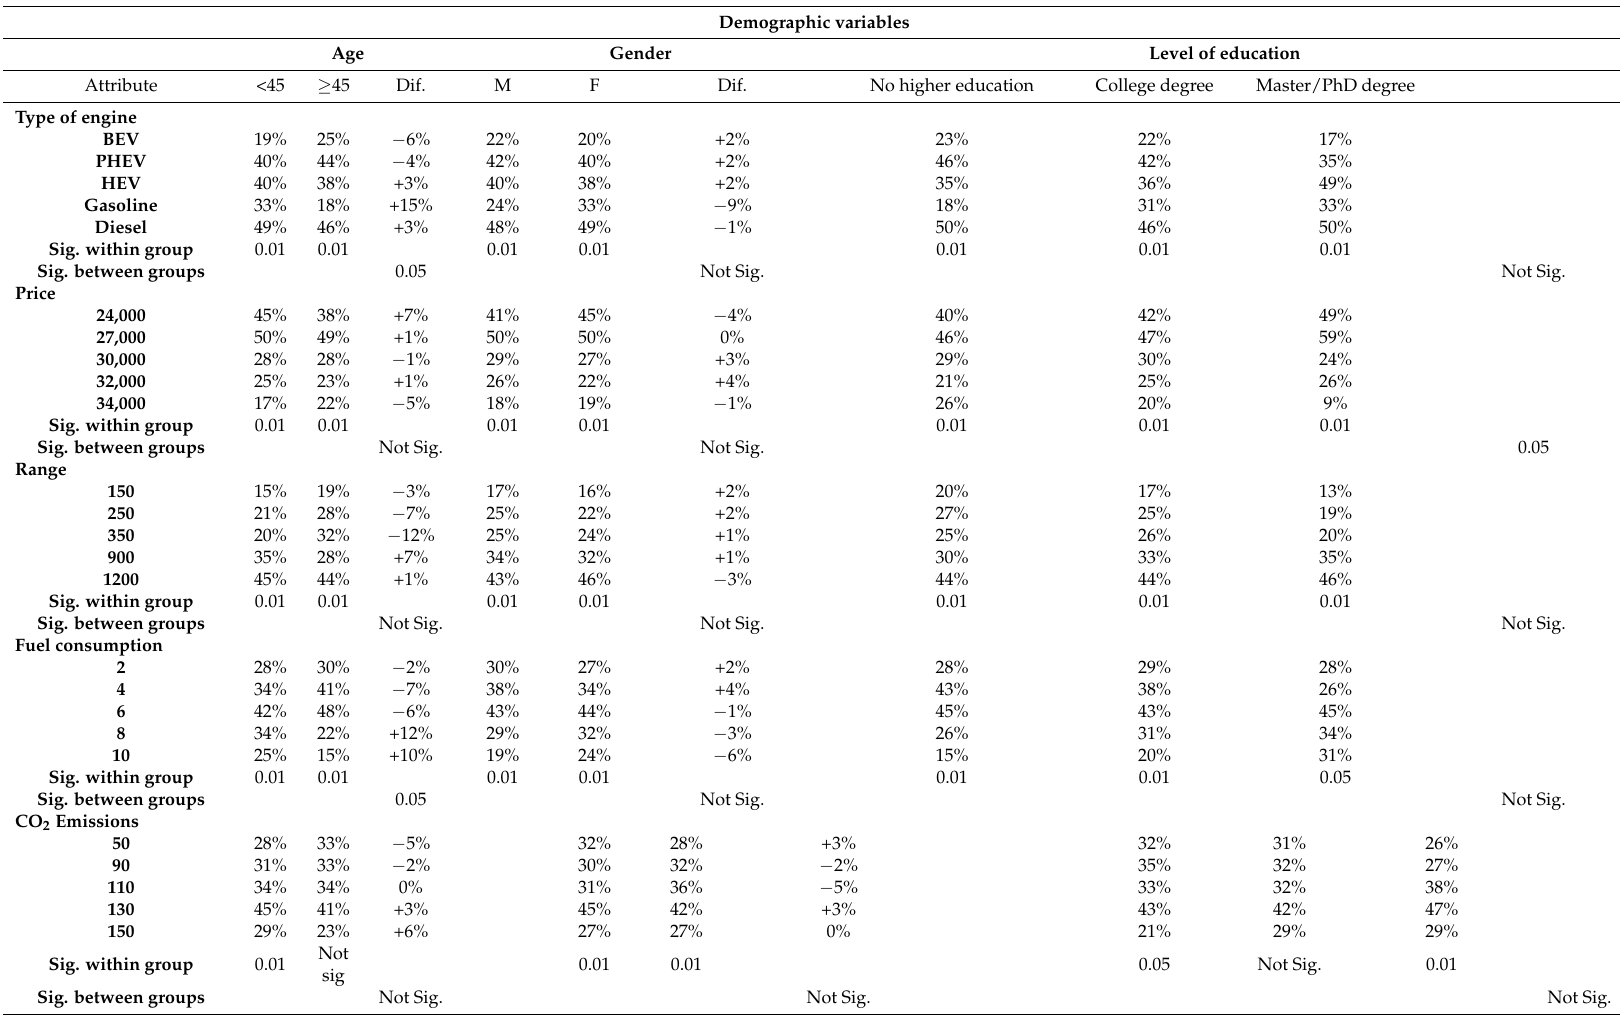
Table 5. Counting analysis for each consumer